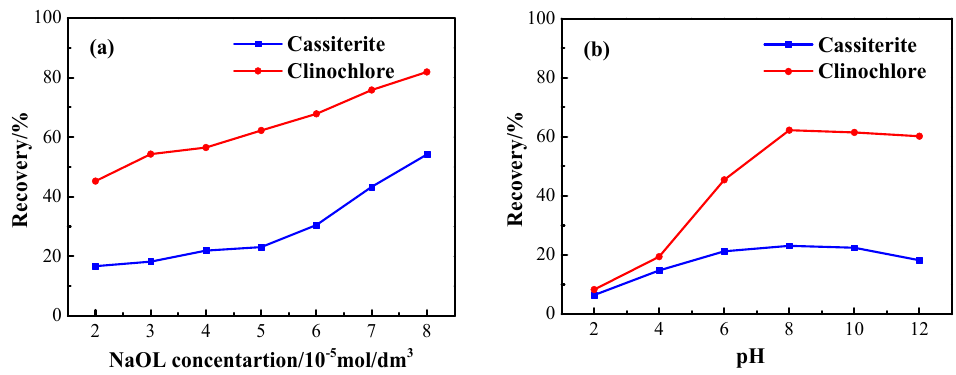
Figure 2. Effect of ( a ) NaOL concentration (at pH 8.0) and ( b ) pH values (at NaOL concentration of 5 × 10 −5 mol/dm 3 ) on floatability of cassiterite and clinochlore.